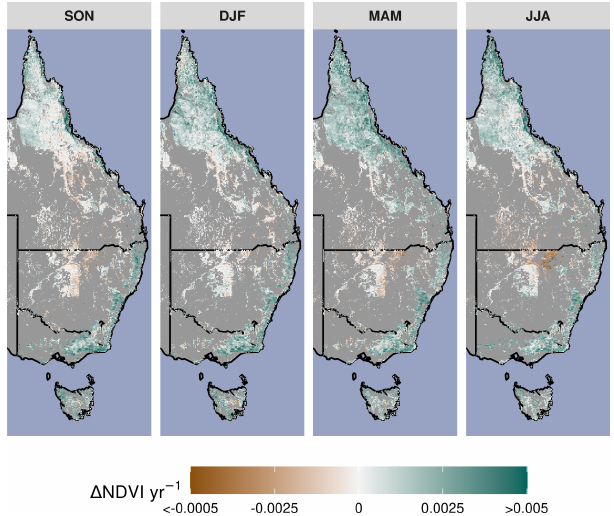
Figure A3. The long-term seasonal NDVI linear trend between 1982–2019. The Theil–Sen robust linear trend estimator is used with the calibrated merger of the CDR AVHRR (1982–2000) and MODIS MCD43 (2001–2019) surface reflectance products.